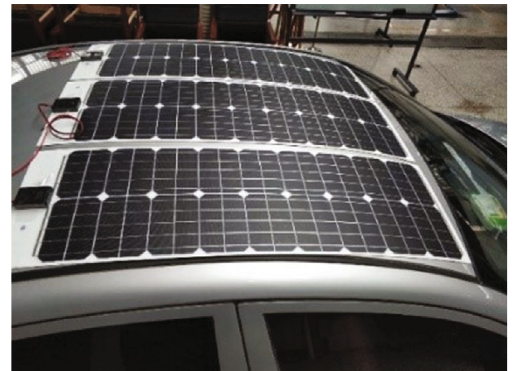
Figure 3: Physical diagram of a vehicle photovoltaic system.